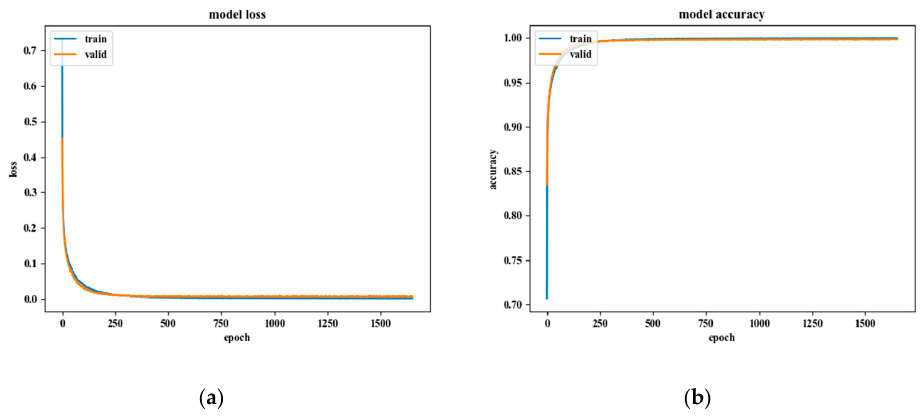
Figure 19. Results of the CNN model training: ( a ) model loss, ( b ) model accuracy.